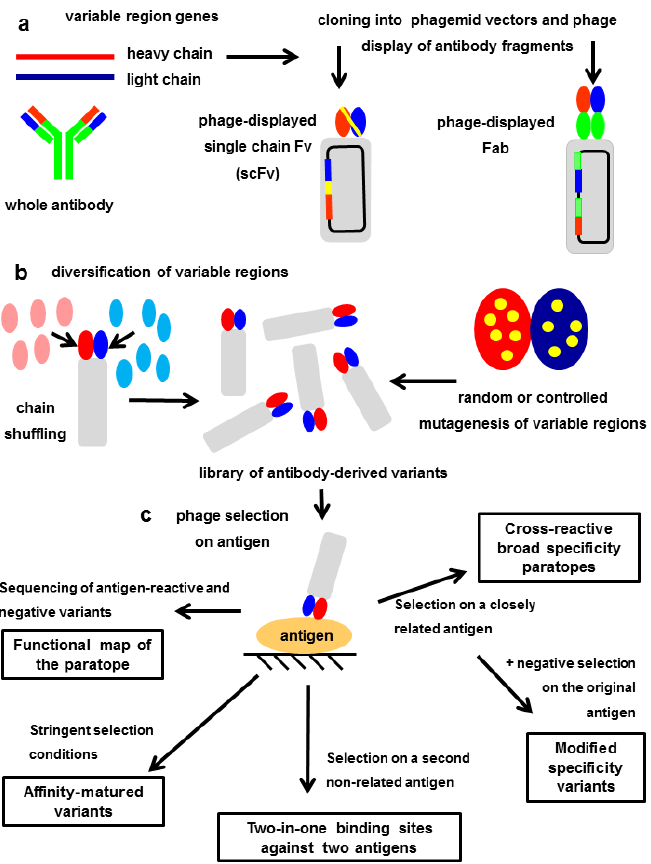
Figure 4. Phage display, characterization and directed evolution of antibody fragments ( a ) Cloning of antibody variable regions and display of functional scFv and Fab antibody fragments. ( b ) Large libraries of phage-displayed antibody fragments are obtained by replacing either heavy or light chain variable regions with diverse collections of homologous variable regions (chain shuffling), or by introducing random/controlled mutations within them. ( c ) Phage panning on an immobilized antigen leads to segregation of variants keeping antigen reactivity and negative variants. The analysis of their sequence profiles reveals those critical residues required for recognition, and de- lineates a functional map of the paratope. Alternative selection strategies can result in fine-tuning of binding properties. Stringent selection conditions allow the isolation of antibody fragments with increased target affinity (in vitro affinity maturation). Selection on a second antigen structurally related to the original one gives rise to either cross-reactive binders with broader specificity, or new binding sites with a subtle specificity change (if variants recognizing the original antigen are ex- cluded during panning). Selection on a second nonrelated antigen can result in the generation of new binding sites with dual specificity.